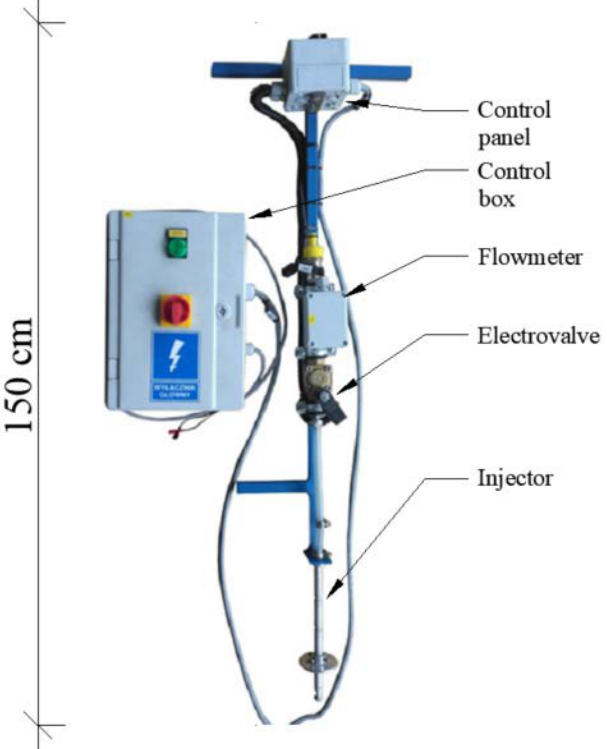
Figure 3. Prototype injector for precision application of water into the physical model at desired depth [54].